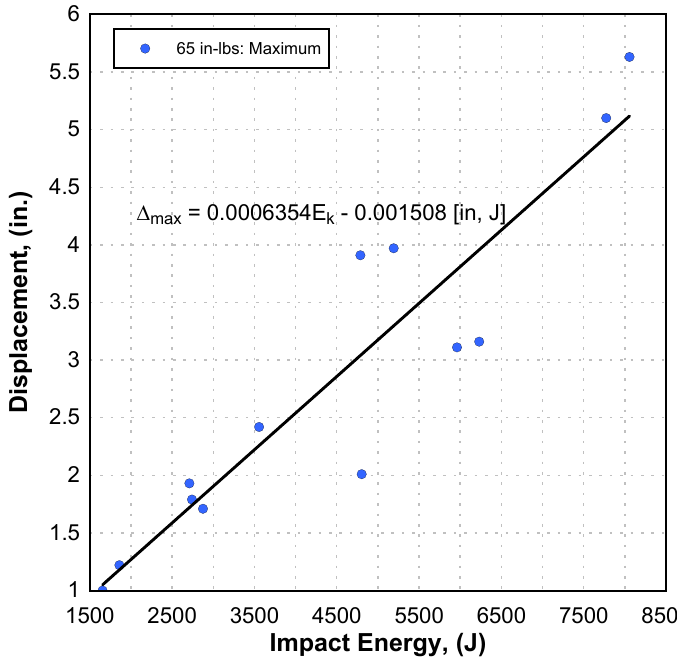
Figure 29. Maximum inbound displacements for three-laminae specimens.